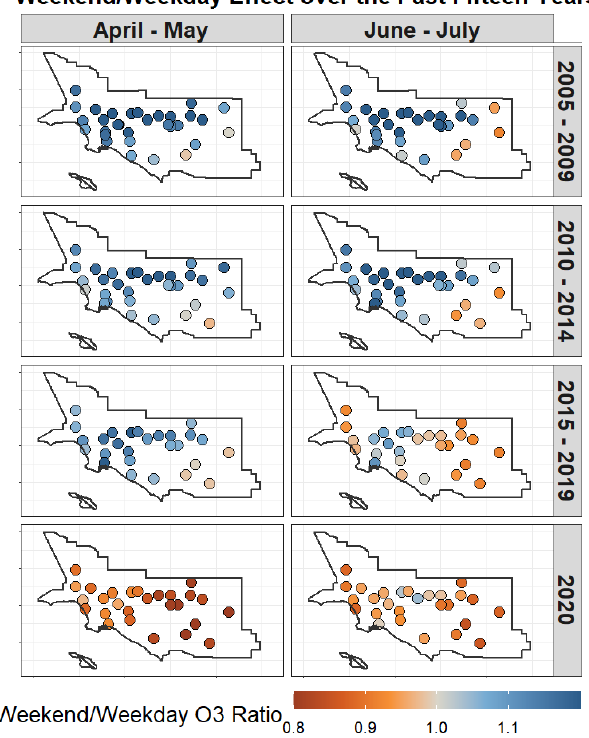
Figure 7. Time series of WE / WD O 3 ratios at SoCAB monitoring sites. Rows represent averages over 5-year bins, and columns repre- sent temporal bins for spring (April–May) and summer